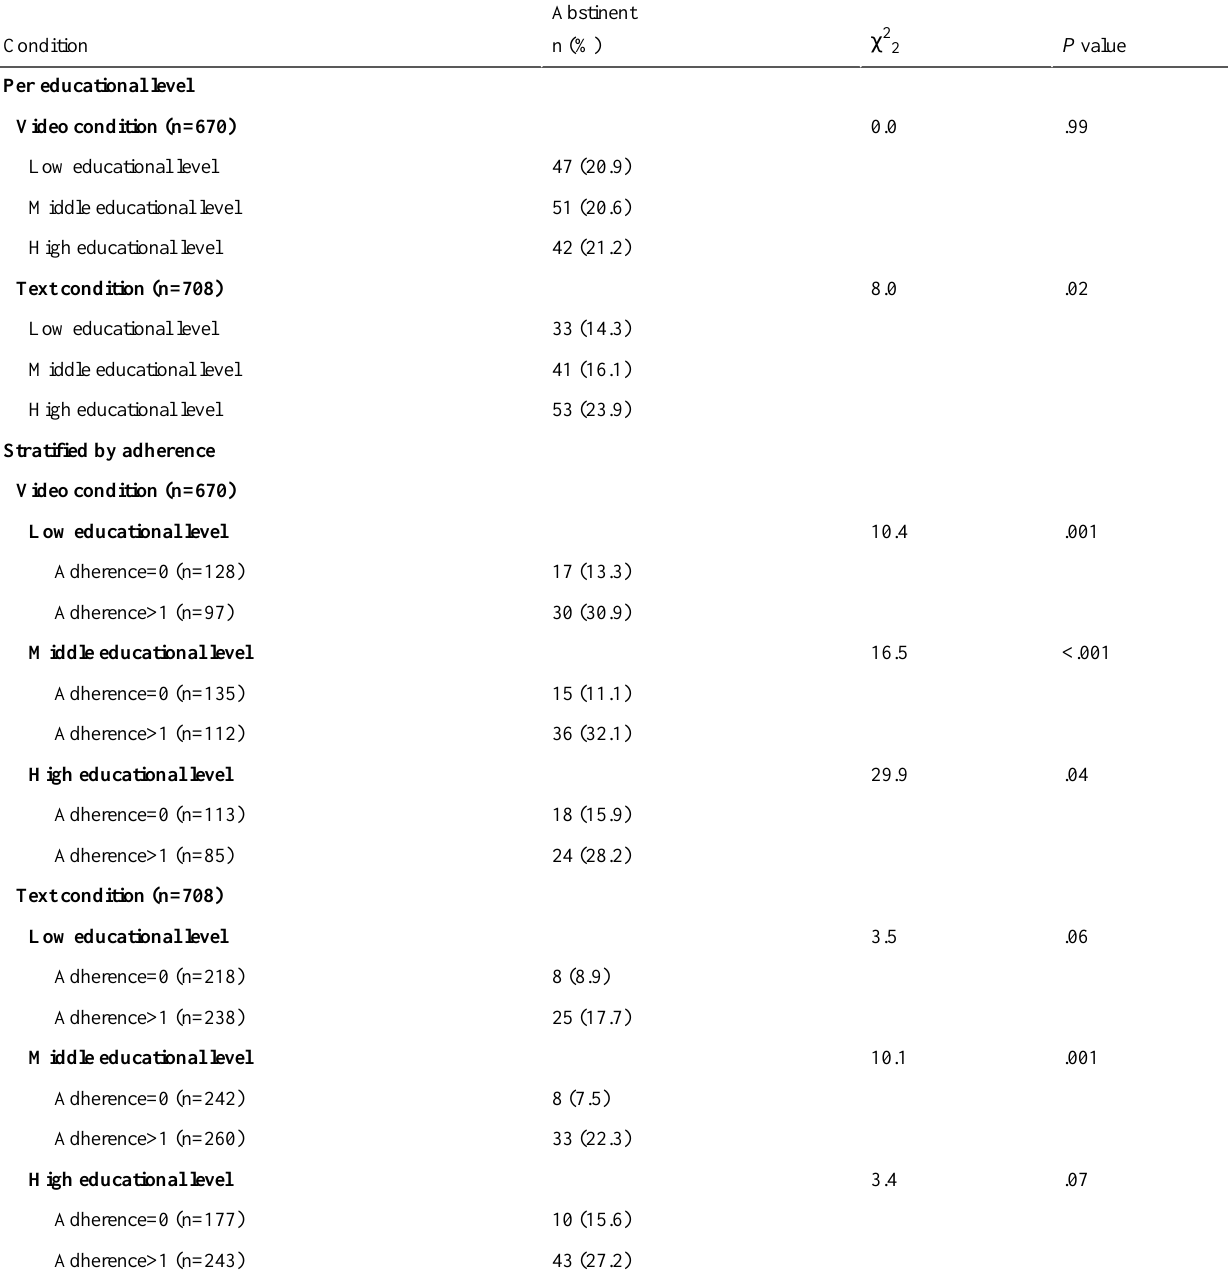
Table 5. Abstinence rates per educational level for the video-based and text-based computer tailoring interventions, stratified by